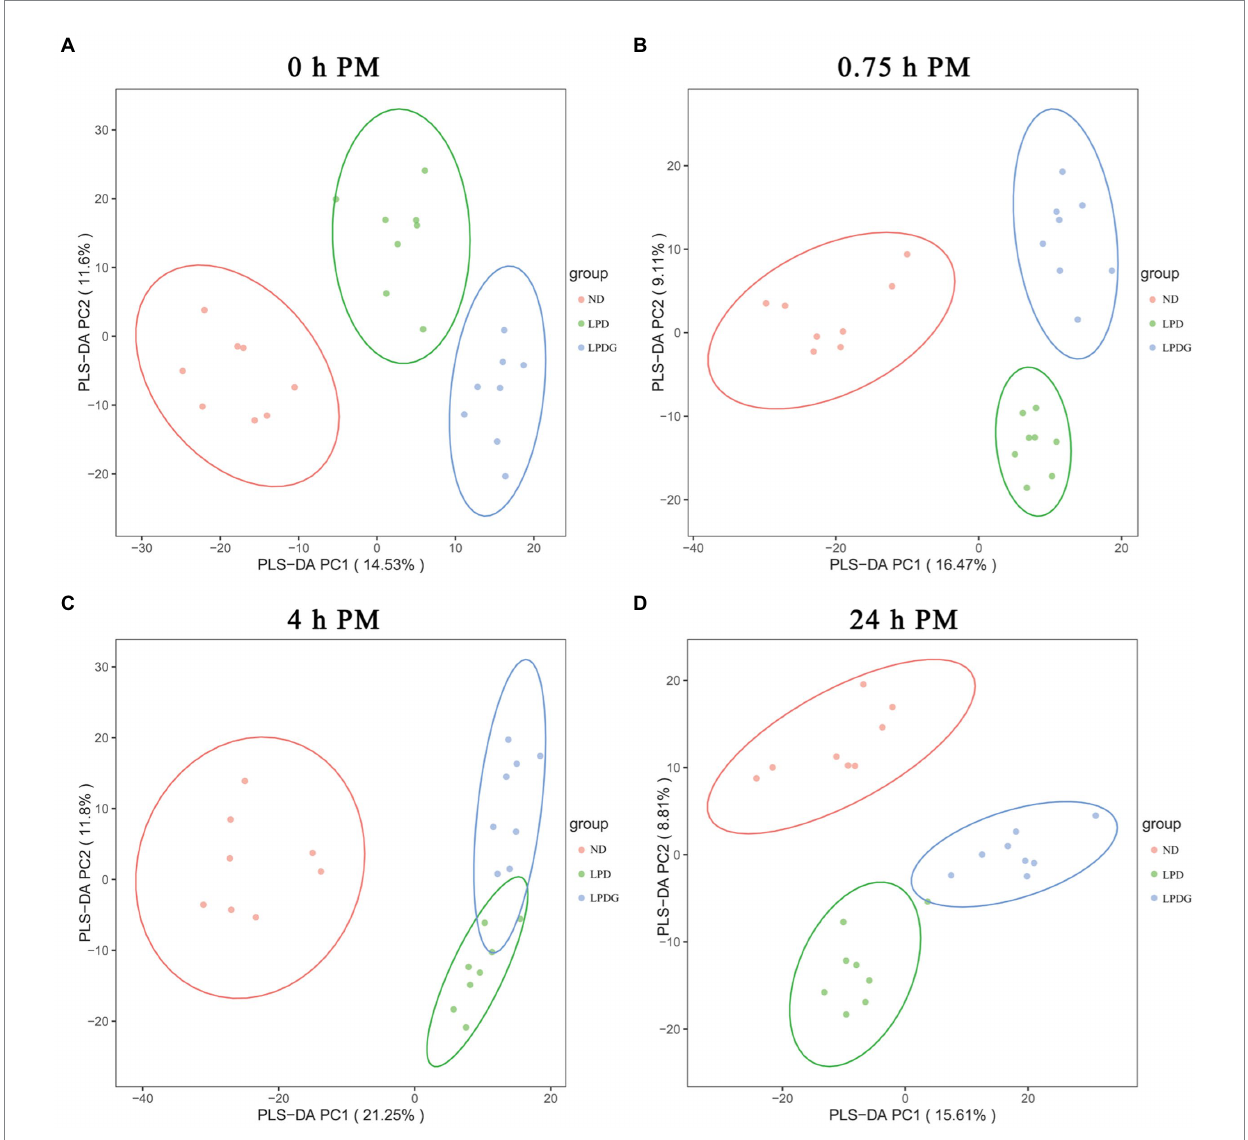
FIGURE 2 The PLS-DA score plot of metabolites in LT muscle from pigs receiving anormal, low protein, or low protein supplemented with glycine